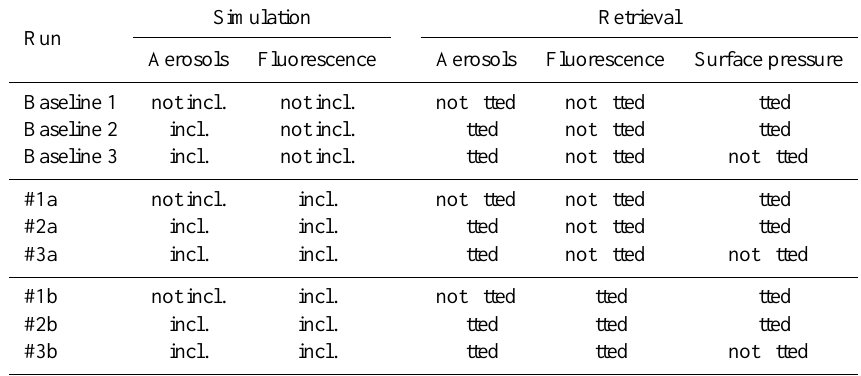
Table 2. Simulation and retrieval setups used in the sensitivity studies. Baseline runs are the benchmark for business as usual (fluorescence neither simulated nor retrieved), runs #xa have fluorescence in the simulation but ignore them in the retrieval, and runs #xb attempt to fit fluorescence in the retrieval as well. Simulation Retrieval Run Aerosols Fluorescence Aerosols Fluorescence Surface pressure Baseline